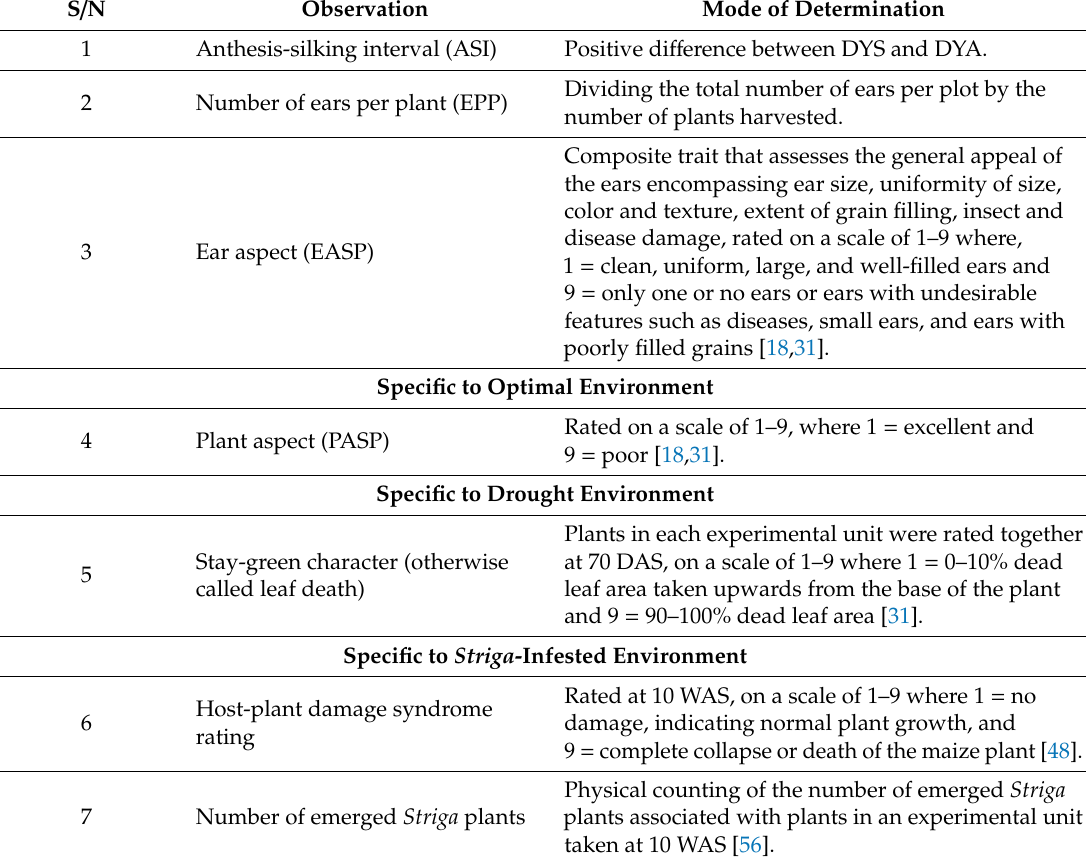
Table 2. Plant observations and their mode of determination for 256 maize hybrids from 2015 to 2017, under individual and across